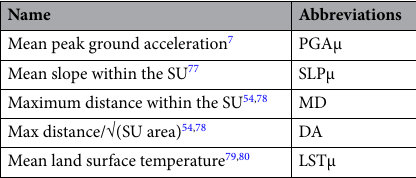
Table 1. List of covariates used in the